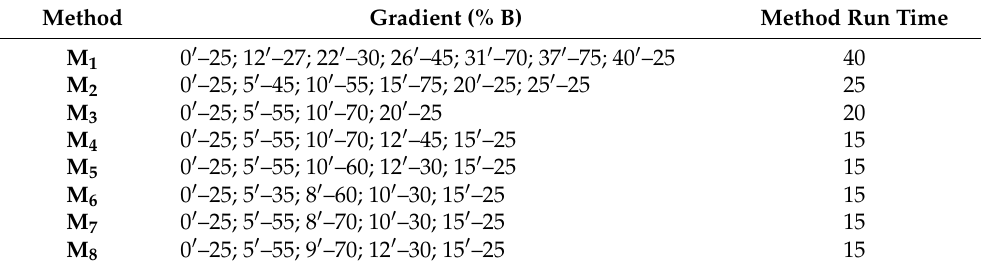
Table 1. The chromatographic parameters used for HPLC method development and